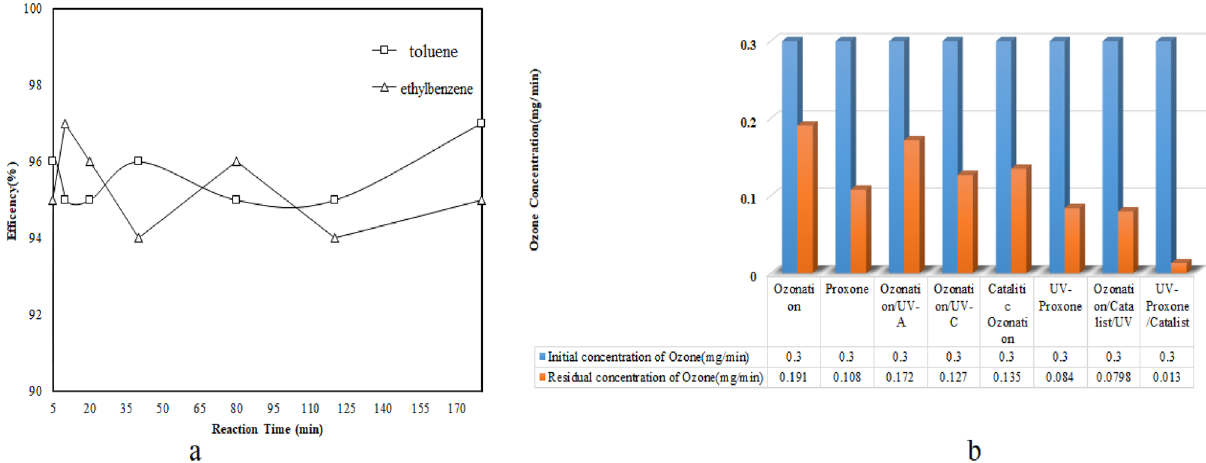
Figure 8. ( a ) Process stability, and reusability of catalyst, ( b ) Residual Ozone in processes (pollutants = 50 ppmv, RH = 45 ± 3,